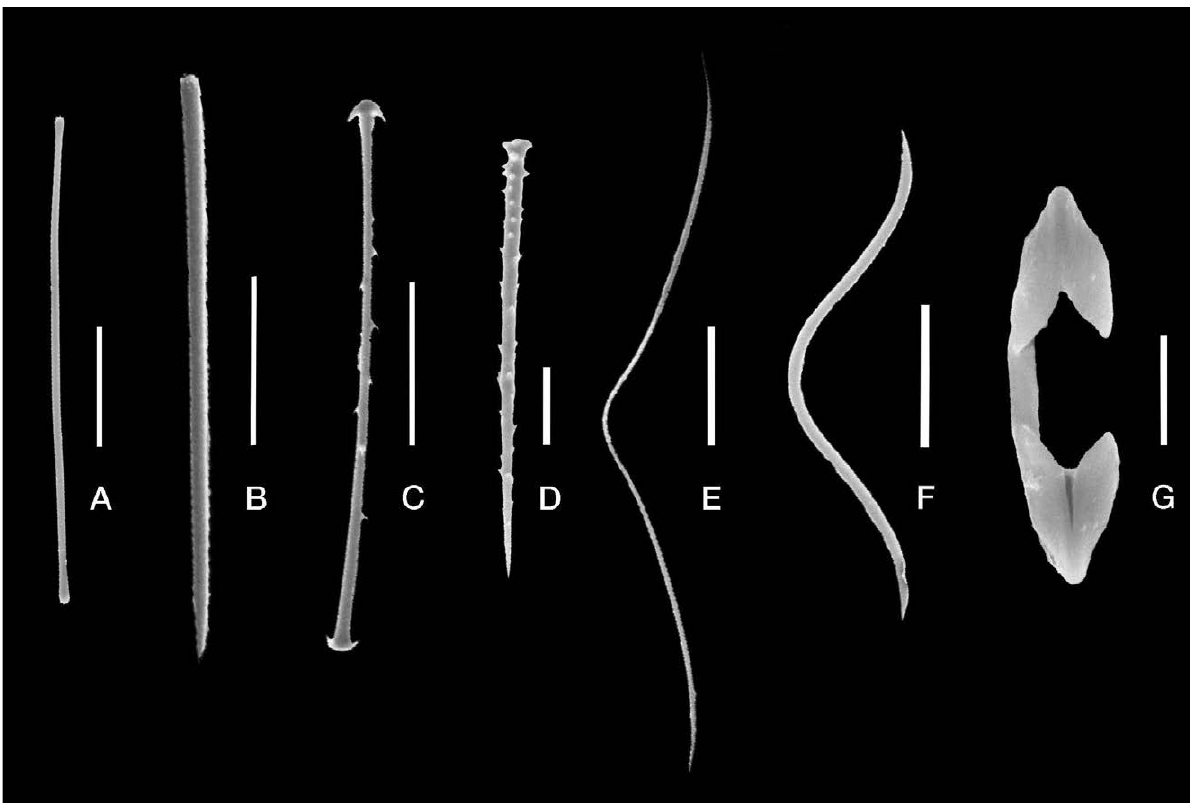
Fig . 5. – Acarnus michoacanensis n. sp. A, Ectosomal tylote with microspined heads. B, Choanosomal style with microspined base. C, Cladoylote microspined with four clades. D, Echinating acanthostyle. E, Toxa I. F, Toxa II. G, Palmate isochela. Scale: A, E, 35 μm; B,